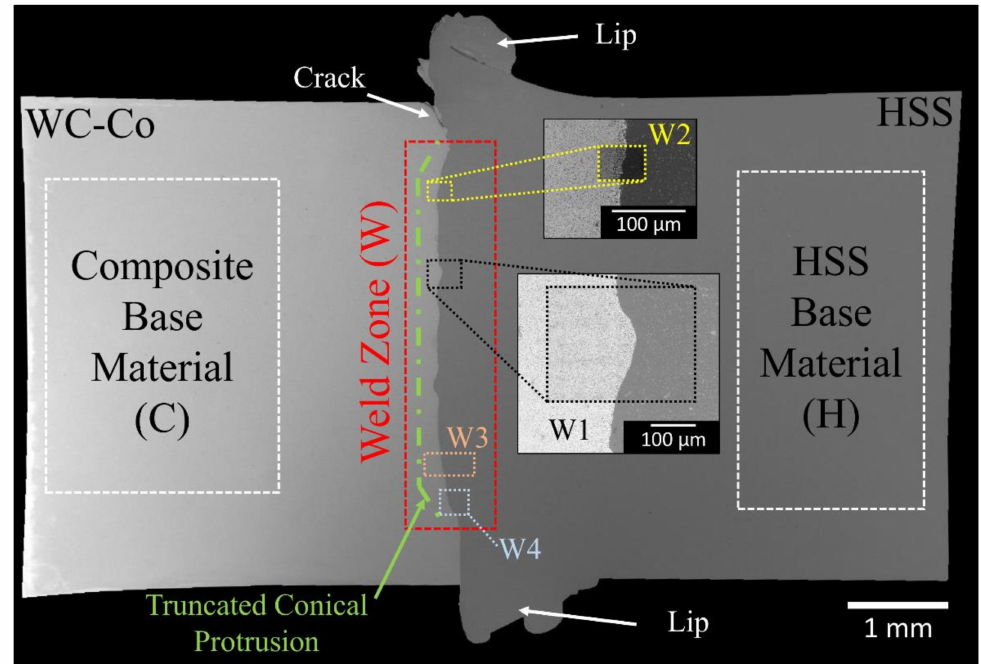
Figure 2. Field emission scanning electron microscopy (FESEM) image of the cross-sectional view of the high-speed steel / cemented carbide (HSS / WC-Co) welded joint after chemo-mechanical polishing. Notation: (C) composite base material, (H) HSS base material and (W) weld zone. Definition of subregions W1 to W4. The green dashed line indicates truncated conical protrusion. The white arrows indicate the extruded HSS lips and a crack in the upper